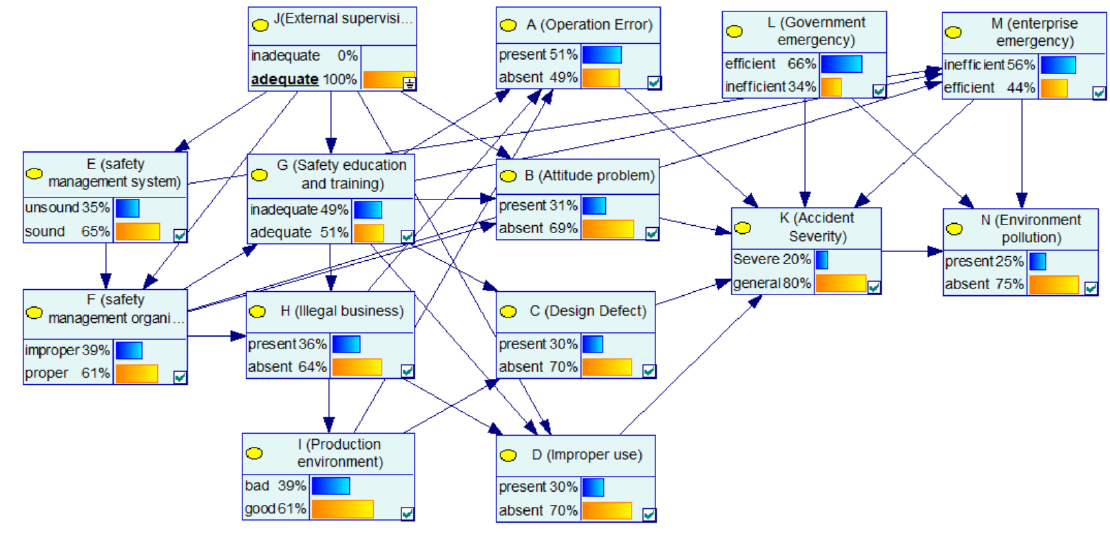
Figure 9. The posterior probability of other nodes when the state of the J node is adequate.